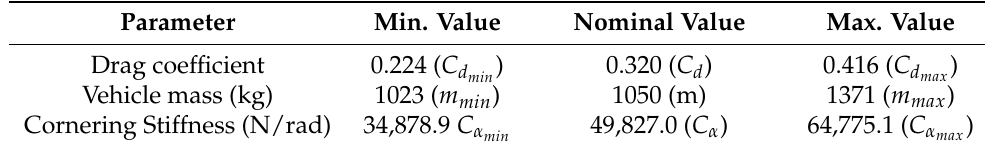
Table 7. Parametric variations of the ego-vehicle